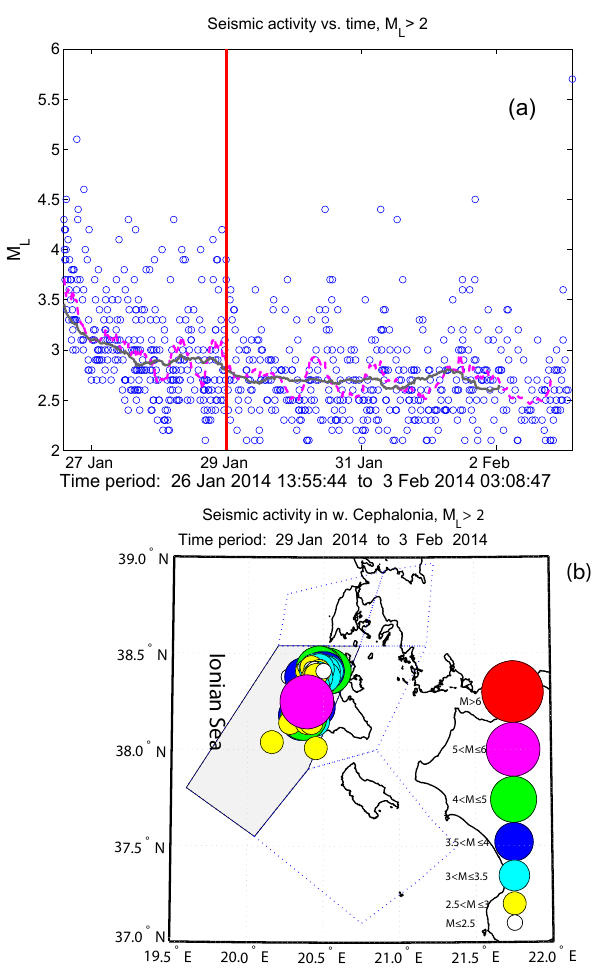
Figure 11. (a) Seismic activity from the time immediately after EQ1 ( M w = 6 . 0 ) up to the time of EQ2 ( M w = 5 . 9 ) for the whole investigated area of the Ionian Sea. The moving averages of the recorded earthquake local magnitudes vs. time for calculation win- dows of 25 and 75 successive events are shown by the dashed magenta and solid grey curve, respectively. The vertical solid red line denotes the time point 29 January 00:00:00UT. (b) The seis- mic activity considered to be foreshocks before EQ2 (from 29 Jan- uary 2014 00:00UT up to the time of occurrence of EQ2) for western Cephalonia. All presented magnitudes are local magnitudes ( M L ) . (For interpretation of the references to colours, the reader is referred to the online version of this